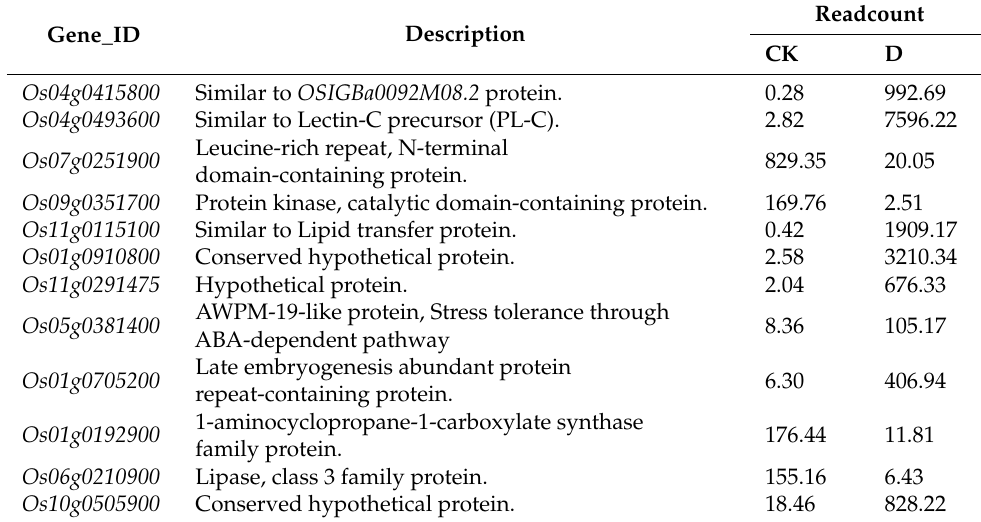
Table 4. Differentially expressed gene information before and after drought